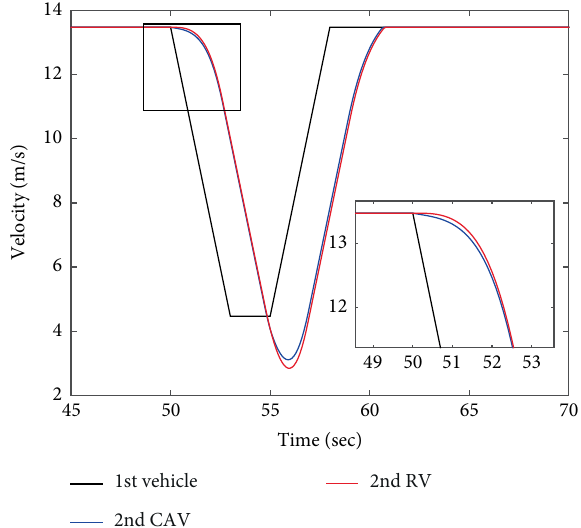
Figure 6: Velocity trajectories of 2nd vehicle and 1st vehicle in 45–70 s in two simulations.